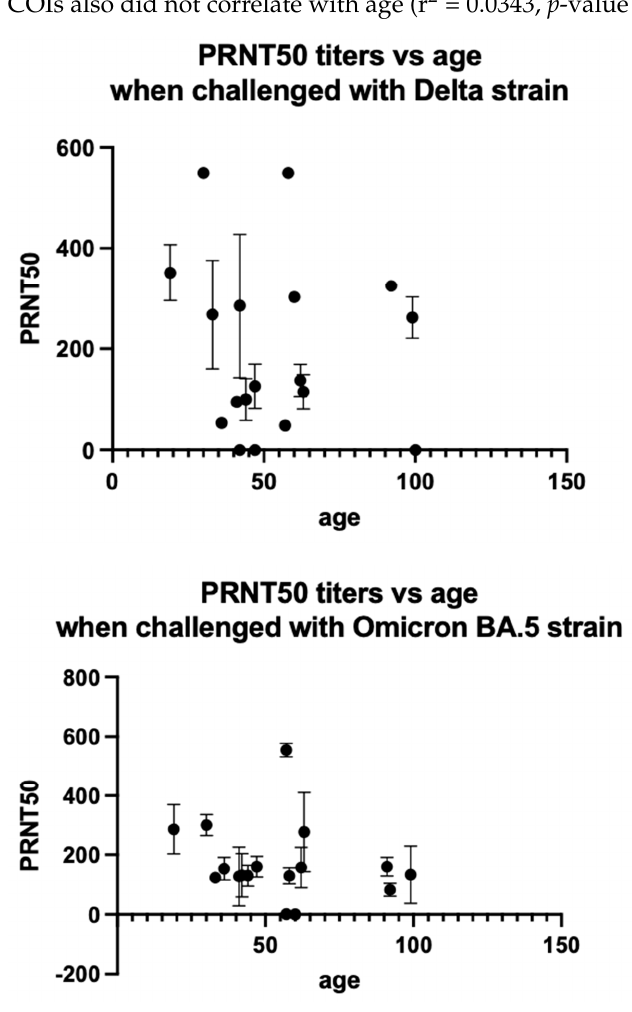
Figure 4. Correlation of PRNT50 titers with age when challenged with Delta and Omicron variants of SARS-CoV-2. Viral load of 6 × 10 3 PFU/mL (30 plaques/well) were added to Vero-E6 cells. Data represented mean ± SD of two biological replicates. µ = 0.05.